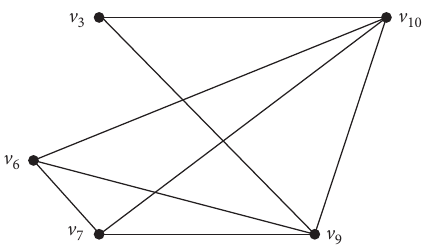
Figure 1: Graph G I ( Λ ), where Λ = < 3, 5, 7 > and I ={11, 12, 13,